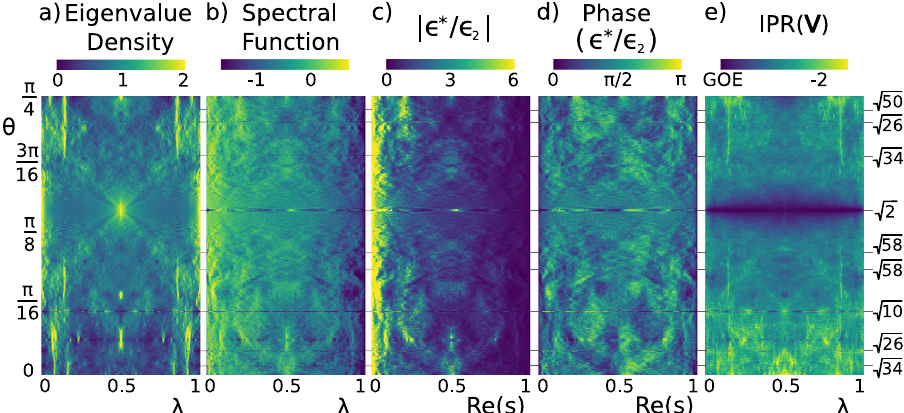
Fig. 5 Twist angle dependence. ( a ) Eigenvalue density ρ ( λ , θ ) (a histogram representation of the density of states ∑ j δ ( λ − λ j )/ N 1 ), ( b ) the spectral function μ ( λ , θ ) (a kernel estimate representation of the spectral measure), ( c ) magnitude and ( d ) phase of relative effective complex permittivity ϵ * / ϵ 2 , and ( e ) a histogram-like representation of the inverse participation ratio (IPR) (median IPR of eigenstates associated with each bin – to distinguish mobility edges), ffiffiffi p = 2. We plot these quantities for one full period 0 ≤ θ ≤ π /4. ( a ), ( b ), and ( e ) are all plotted versus the Moiré twist angle θ for scale parameter r ¼ 5 plotted versus eigenvalue 0 ≤ λ ≤ 1, while ( c ) and ( d ) are plotted versus 0 ≤ Re s ≤ 1 for Im s ¼ 0 : 001. Low and high density for ρ and μ and are indicated by dark blue and yellow, respectively, as shown by the color bars (with linear scale in ( a ), ( c ), and ( e ) and log 10 scale in ( b ) and ( e ), slightly saturated at the ends to reveal more detail). Short period systems appear as horizontal streaks; for ρ and μ sharp isolated resonances are identi fi ed by localized yellow resonant peaks surrounded by dark blue troughs with values orders of magnitude smaller. The in fl uence of μ on ϵ * / ϵ 2 is clear, with striking similarities. For the IPR in ( e ) extended and localized vectors are identi fi ed by dark blue (with GOE value labeled) and yellow, with mobility edges indicated by sudden changes from one extreme to the other. Some of the θ values associated with these short period systems are identi fi ed by black tick marks on the right, ffiffiffiffiffiffiffiffiffiffiffiffiffiffiffiffi p labeled by the bound K ¼ m 2 þ n 2 on the system